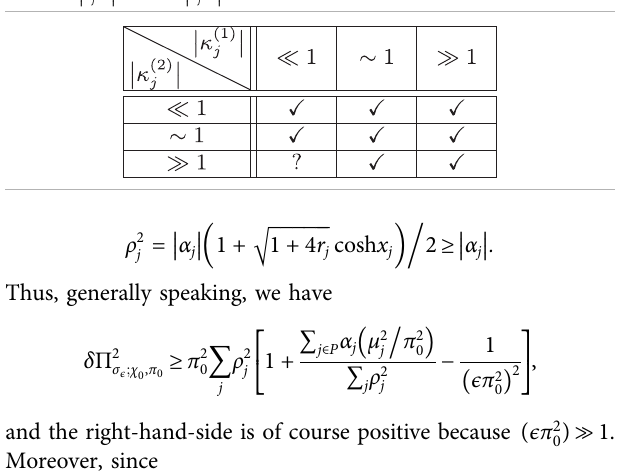
TABLE 1 | Validity of the condition ( Eq. 46 ) depending on the scales κ ( 1 ) j and κ ( 2 ) j